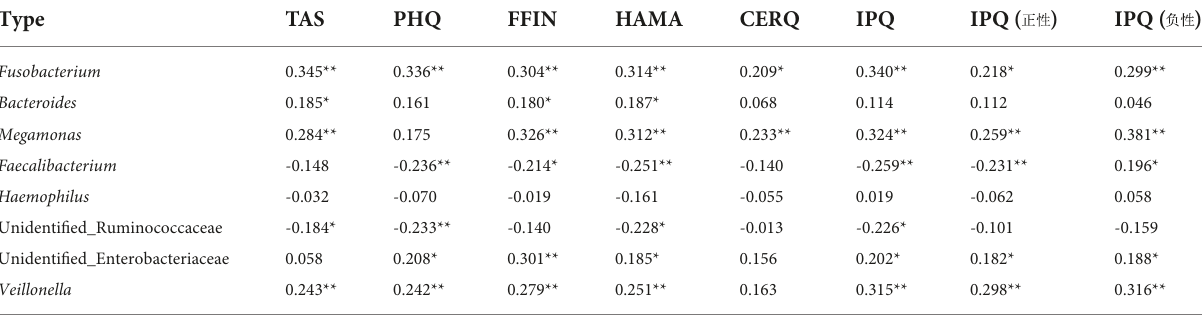
TABLE 3 Correlation analysis of psychosocial factors and intestinal flora (The Rs